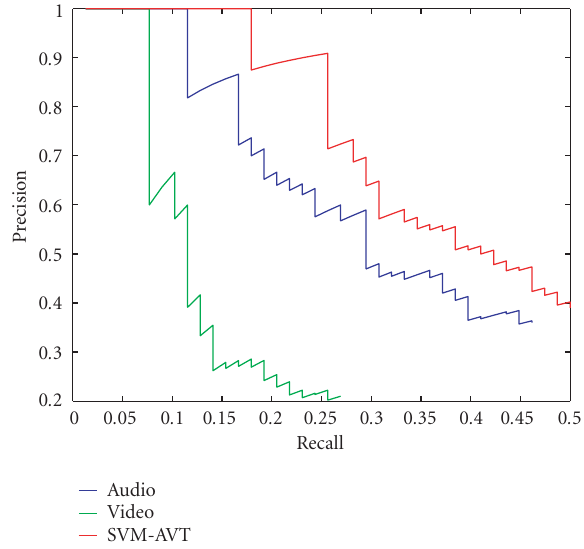
Figure 10: Fusion of audio, text, and visual models using the SVM fusion model for rocket launch